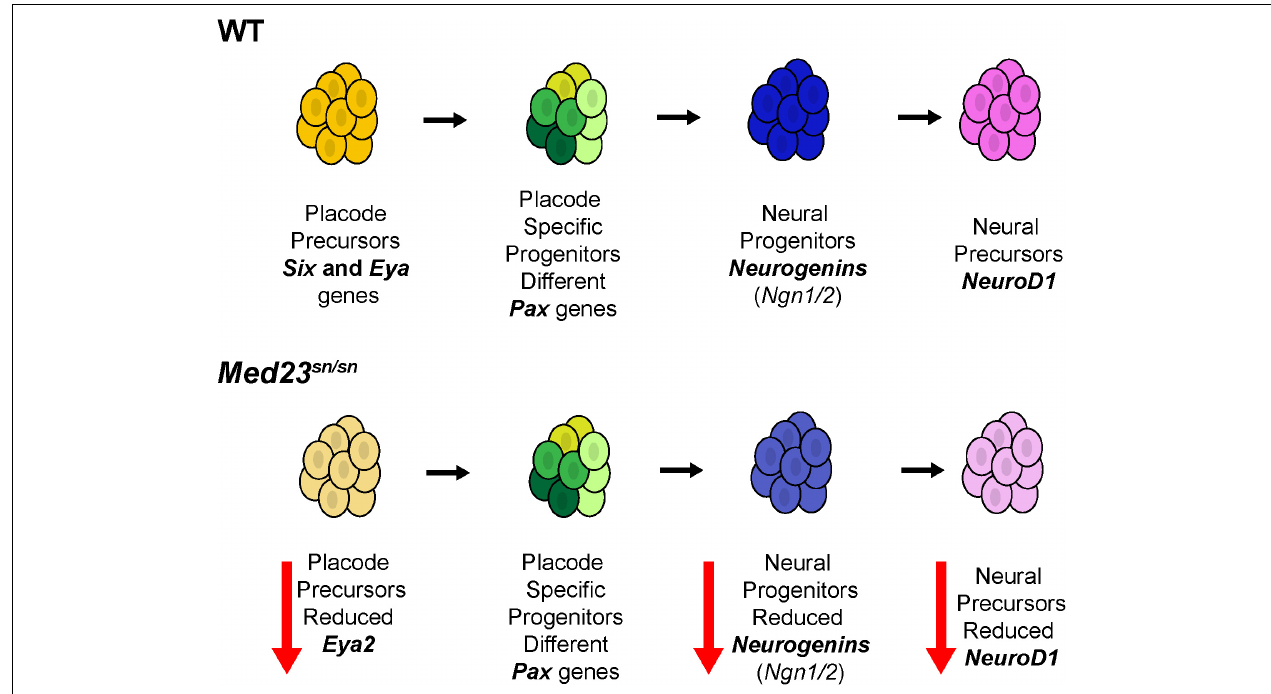
FIGURE 10 | Model for Med23-mediated regulation of cranial placode development. In wild-type embryos, placode precursors express Six and Eya genes. Their subsequent expression of different Pax genes defines them as placode specific progenitor cells. Some of these cells then express Ngn1 and Ngn2 thus becoming neural progenitor cells. Ngn1 and Ngn2 regulate the expression of NeuroD1 which then defines these cells as neural precursors. However, in Med23 sn / sn embryos, placode precursors exhibit reduced Eya2 expression, and although Pax genes are similarly expressed in Med23 sn / sn embryos as they are in wild-type embryos, Ngn1 , Ngn2, and NeuroD1 are downregulated. Collectively, this reduces the number of neural precursors resulting in defects in cranial ganglia development in Med23 sn / sn